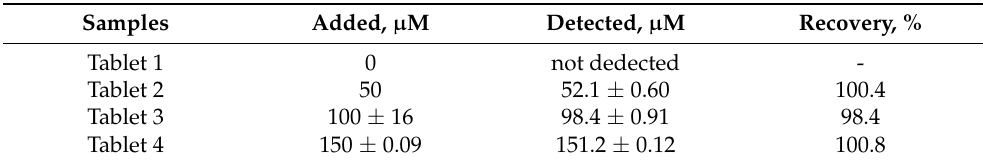
Table 3. Detection of ascorbic acid in